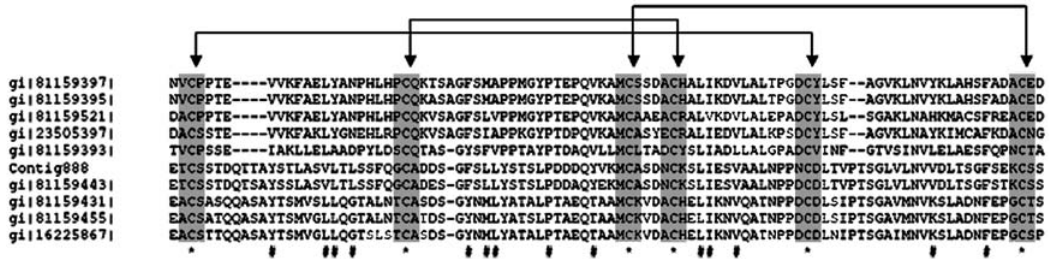
Figure 3 - Multiple alignment of Phytophthora elicitin amino acid sequences and homologies. Cysteine residues involved in disulfide bonds are showed in shaded box. The three conserved disulfide bonds are represented by arrows. Residues that putatively interact with ergosterol are indicated by